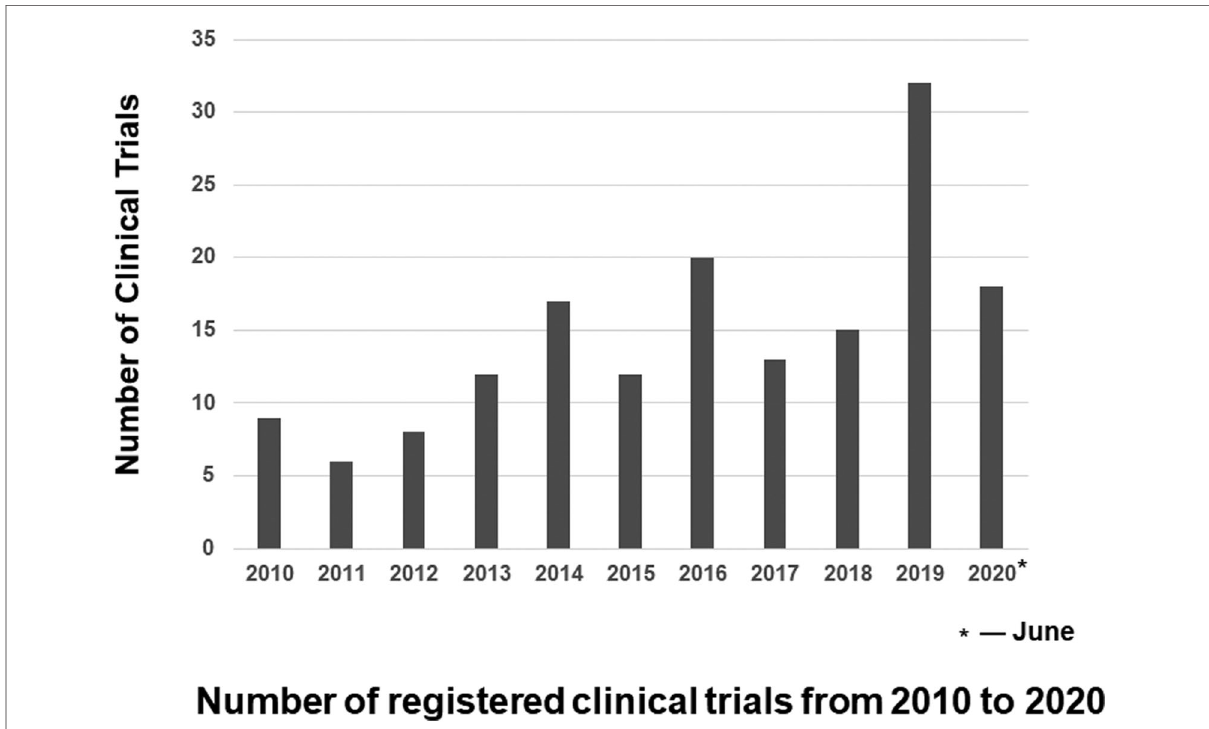
FIGURE 2 Number of registered clinical trials from 2010 to 2020 the number of clinical trials generally increased from 2010 to 2019, and it peaked in 2019 with 32 clinical trials. Because we include clinical trials registered from 2010 and June 2020, the number of clinical trials registered in 2020 is the